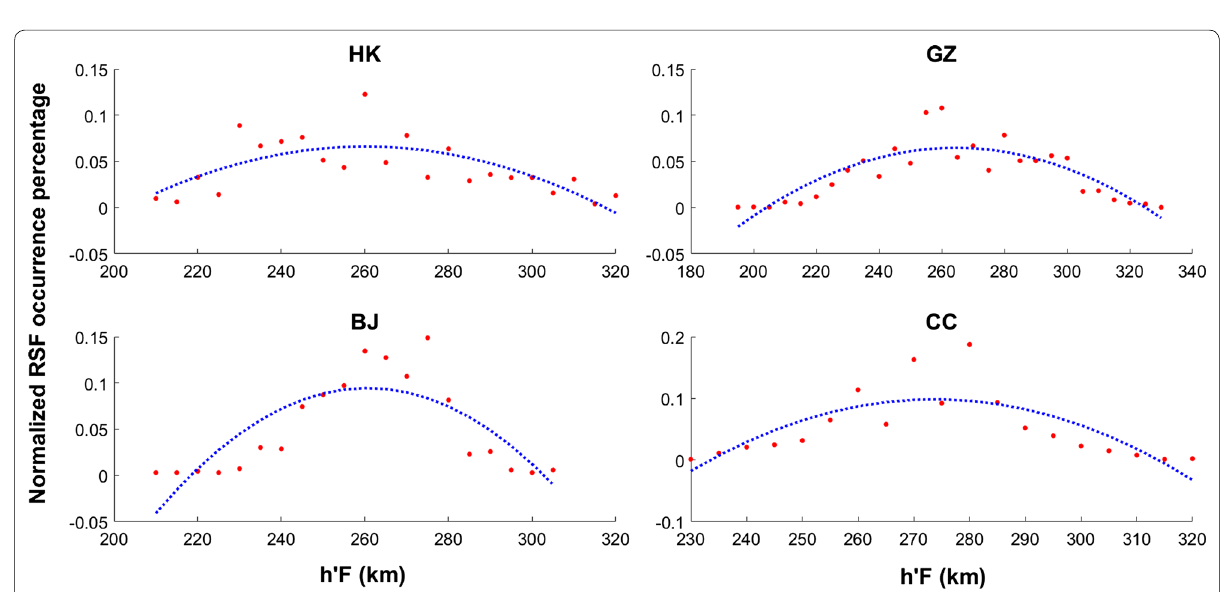
Fig. 13 Correlation between h ′ F and the normalized RSF occurrence